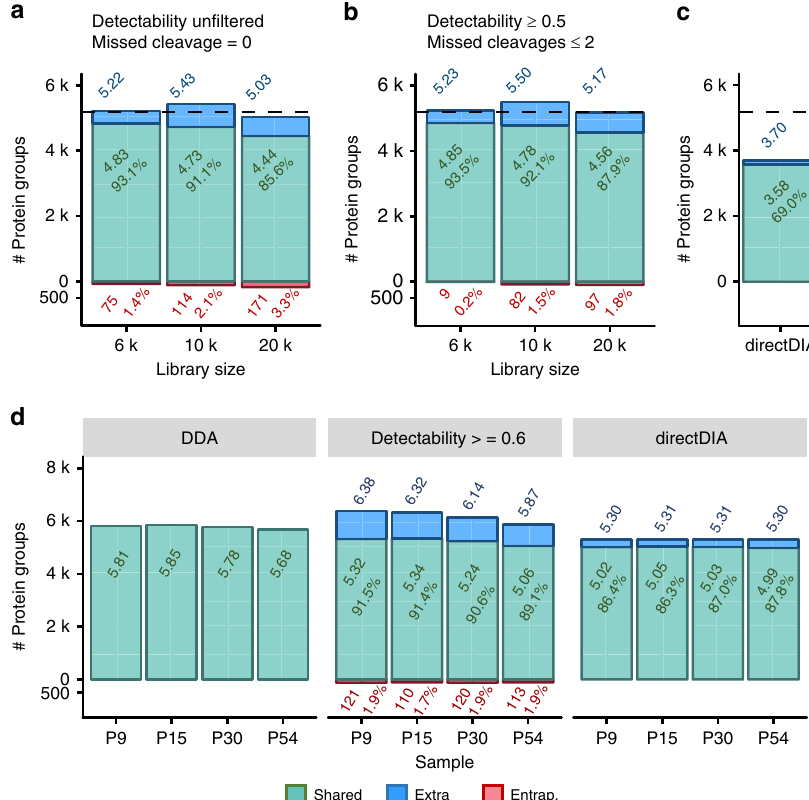
Fig. 4 DIA analysis results using large in silico spectral libraries. a The numbers of protein groups detected from a dataset of HeLa cells (HeLa1) using HeLaProt (6 k proteins), PanProt (10 k proteins), and HumanProt (20 k proteins). The libraries include all in silico tryptic digested peptides without missed cleavage. b The numbers of protein groups detected from HeLa1 using HeLaProt50 (6 k proteins), PanProt50 (10 k proteins), and HumanProt50 (20 k proteins). The libraries include in silico tryptic digested peptides with ≤ 2 missed cleavages and a detectability score ≥ 0.5. c The numbers of protein groups detected from HeLa1 using directDIA. d The numbers of protein groups detected from a dataset of mouse tissue (Mouse1) using the DDA-based library, MouseProt60 (an in silico library generated from SwissProt Mus musculus database with a detectability score threshold of 0.6 and ≤ 2 missed cleavages), and directDIA. Details of the spectral libraries are described in Supplementary Table 2. The dashed lines indicate the numbers of protein groups detected using the DDA-based libraries. Overlapping identi fi cations with the DDA-based libraries are referred as “ shared ” . Protein group numbers, sensitivities and entrapment (Entrap.) percentages are